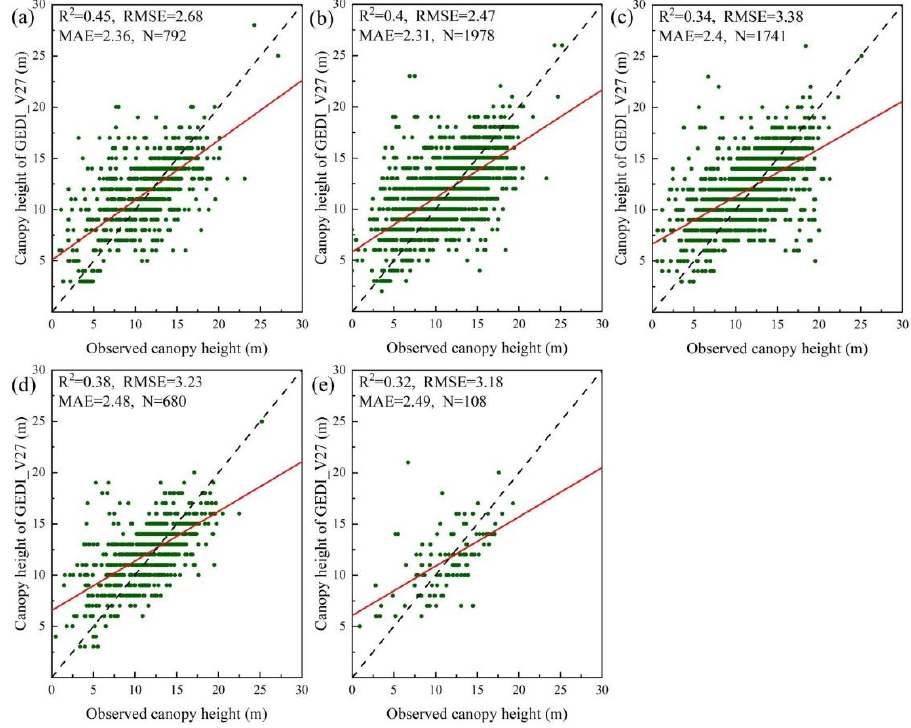
Figure 17. Canopy height accuracy of the GEDI_V27 at five slope levels. ( a ) 0 – 10°. ( b ) 10 – 20°. ( c ) 20 – 30°. ( d ) 30 – 40°. ( e ) >40°.